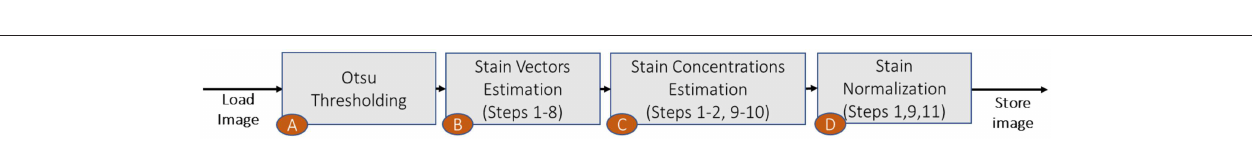
FIGURE 4 | Mapping the steps of Algorithm 1 to our optimized implementation fast_sn .